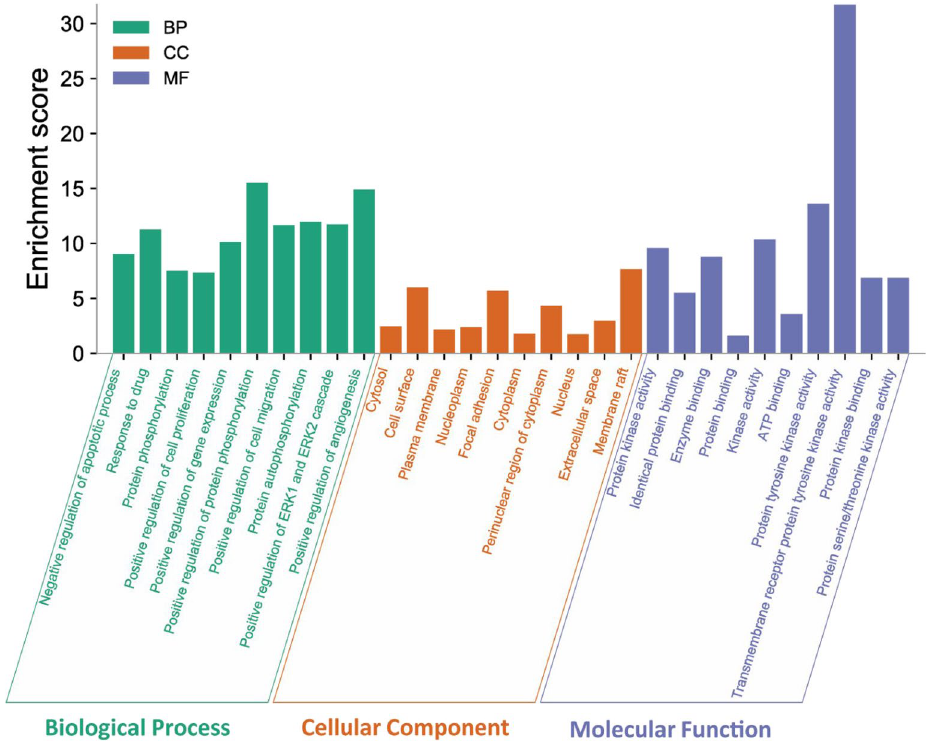
Figure 3. GO enrichment analysis for the targets in andrographolide treating gastric cancer (P value < 0.05) (http:// www. bioin forma tics. com.